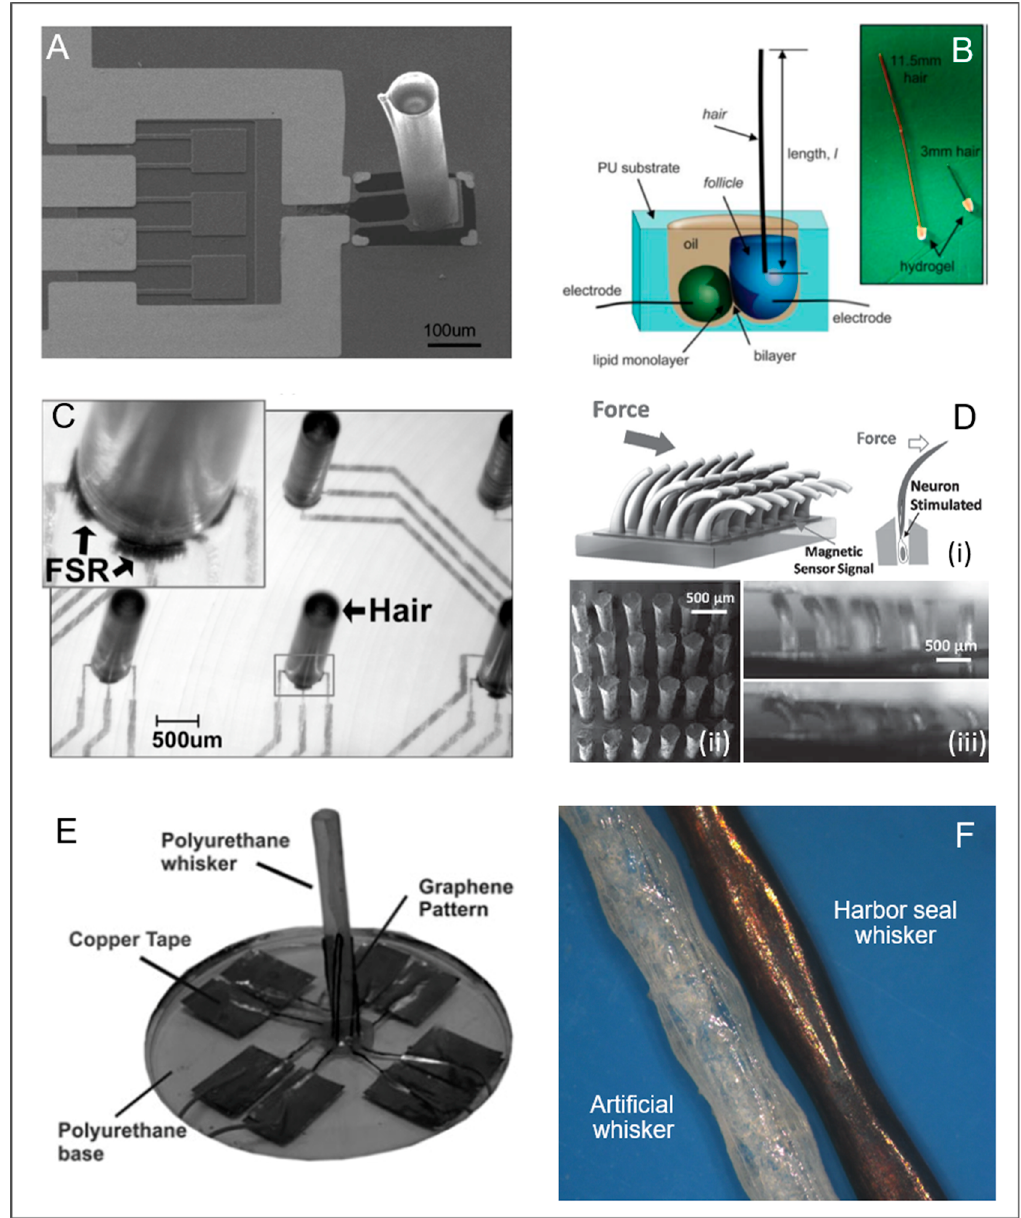
Figure 5 . Artificial sensors integrating cantilever shapes. ( A ) Stiff SU-8 hair sensor (© 2007 IEEE. Reprinted, with permission, from [71]). ( B ) Synthetic fiber in a hydrogel follicle, using a lipid bilayer as the transduction element (reproduced from [76] with permission from The Royal Society of Chemistry). ( C ) Polyurethane force sensitive resistor (FSR) allowing bending (© 2006 IEEE. Reprinted, with permission, from [83]). ( D ) Sensor with array of cilia using magnetoimpedance (reprinted from [84] by permission of John Wiley & Sons, Inc.). ( E ) Artificial whisker with straight cylindrical shape (reproduced from [108]. The publisher for this copyrighted material is Mary Ann Liebert, Inc. publishers). ( F ) Artificial whisker with undulated surface compared to a harbor seal whisker (republished with permission of Annual Reviews, from [49]).